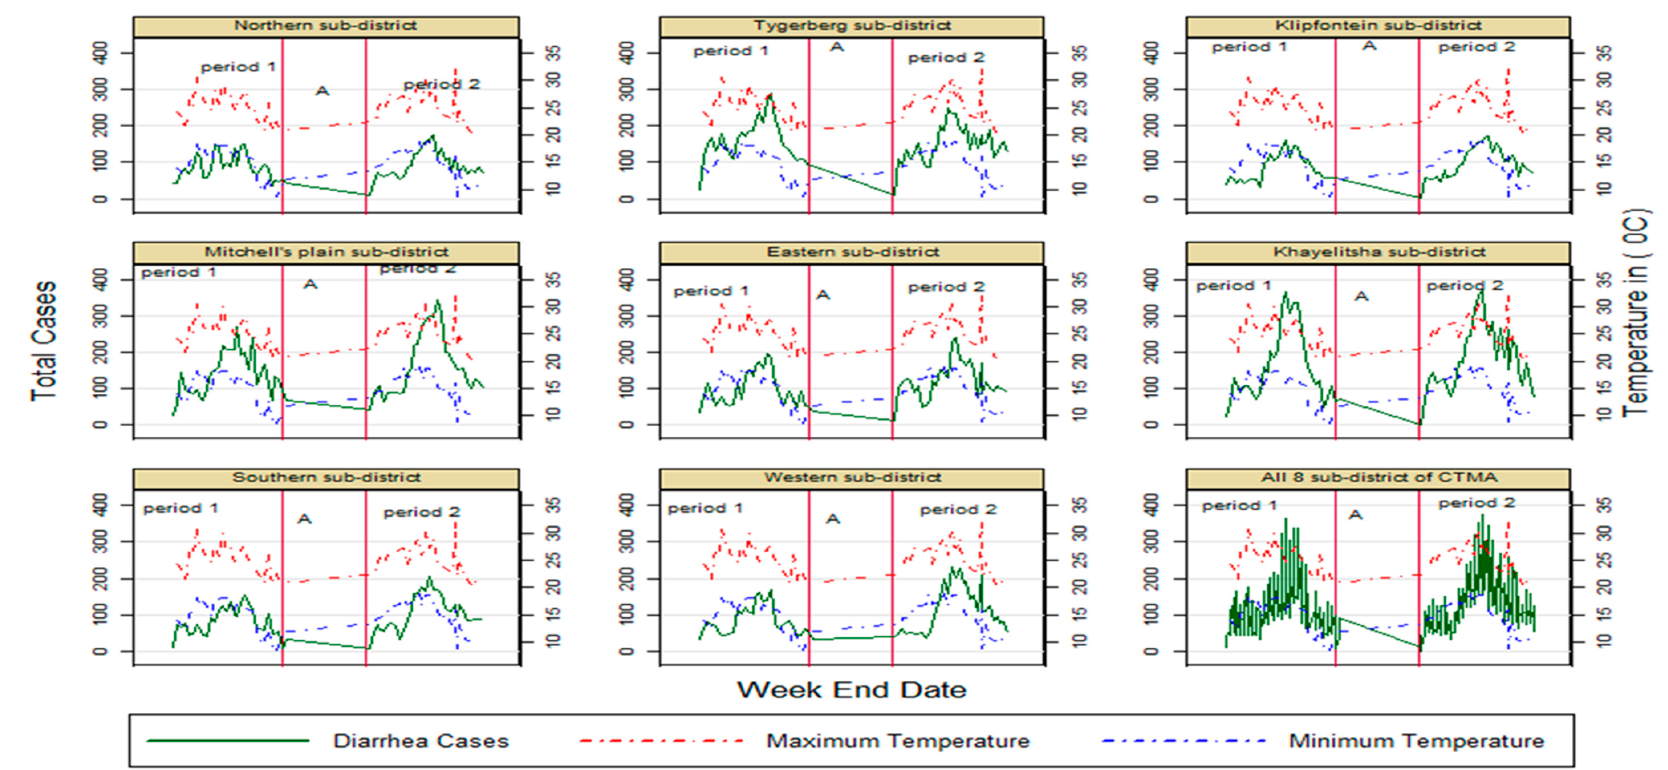
Figure 1. Trend in diarrhoea cases with change in min and max temperature in Cape Town Metropolitan Area CTMA sub-districts and in all eight sub-disricts.